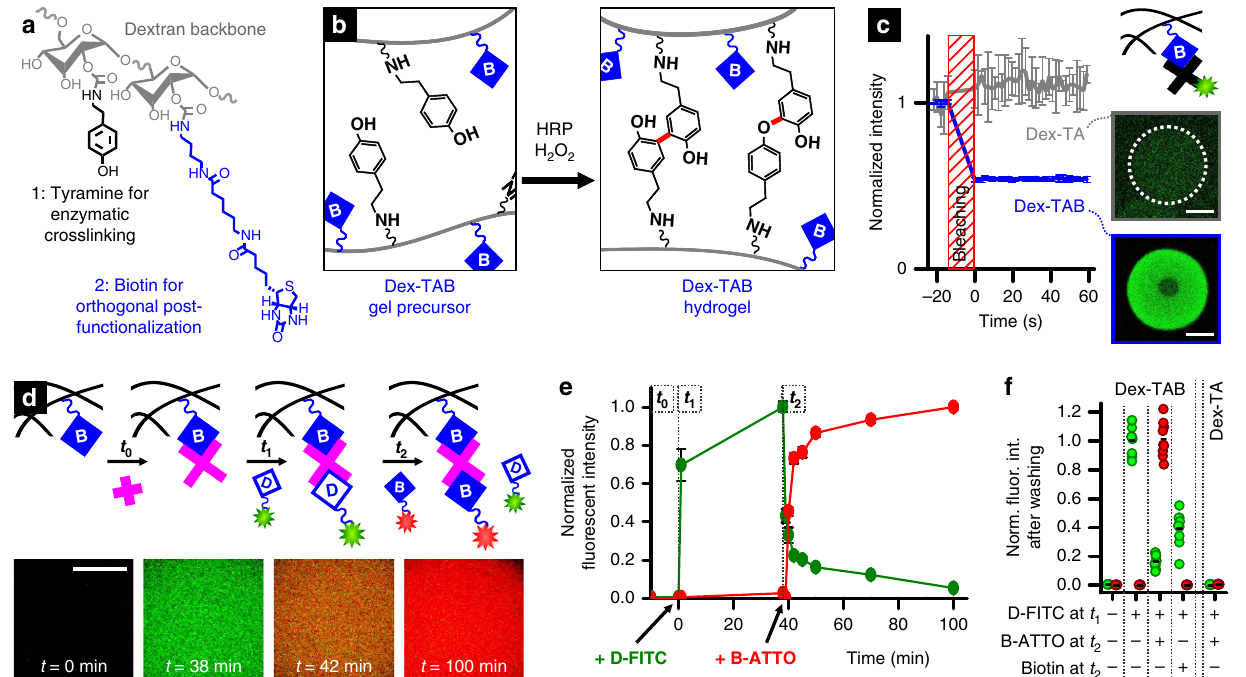
Fig. 2 Temporal control over biotinylated hydrogel. a Dextran was modi fi ed with tyramine and biotin to yield the injectable polymer Dex-TAB. b The phenolic hydroxyl groups in Dex-TAB could be enzymatically crosslinked in situ via the formation of C – C and C – O bonds (red bonds) using horseradish peroxidase (HRP) as catalyst and H 2 O 2 as oxidizer. This effectively resulted in a dextran-based hydrogel with biotin available for orthogonal post- functionalization. c Dex-TAB (blue) and not Dex-TA (gray) could be post-functionalized with fl uorescent streptavidin-FITC in a stable manner, as demonstrated using fl uorescence recovery after photobleaching (FRAP). d On-demand supramolecular complexation and in situ displacement of biochemical moieties within Dex-TAB was demonstrated using D-FITC, B-ATTO, and pristine biotin ( e , f ), which was quanti fi ed using time-lapse fl uorescence confocal microscopy analysis. All green data indicate D-FITC. All red data indicate B-ATTO. All error bars indicate ± standard deviation ( n = 4). All scale bars indicate 10 µ